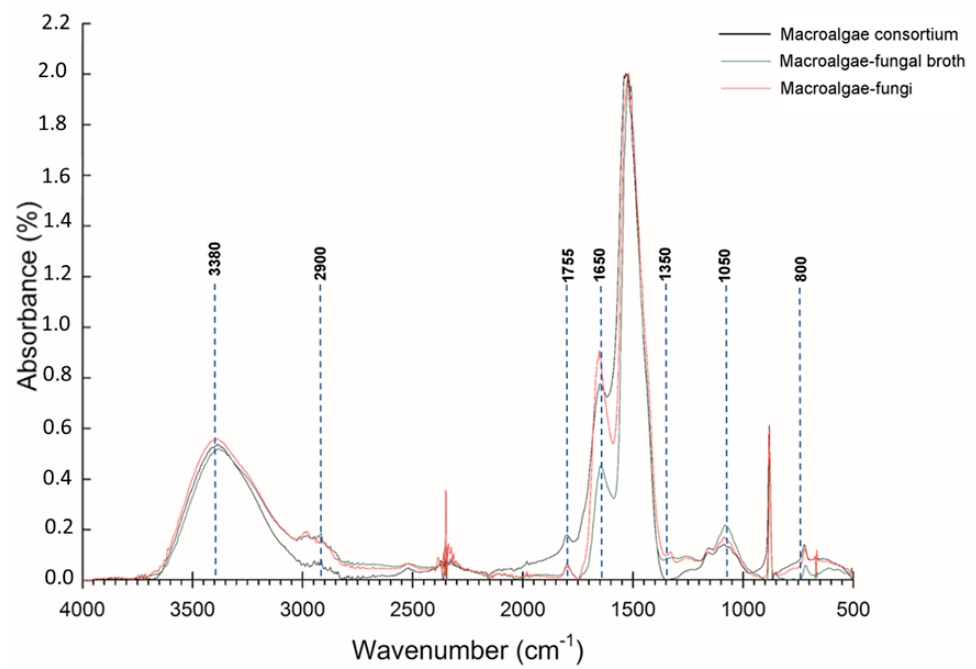
Figure 1. FT-IR spectral of untreated and pretreated macroalgae consortium sample. Black line: macroalgae consortium (Mc), green line: macroalgae–fungal broth (McFb) and red line: macroalgae fungi (McF).